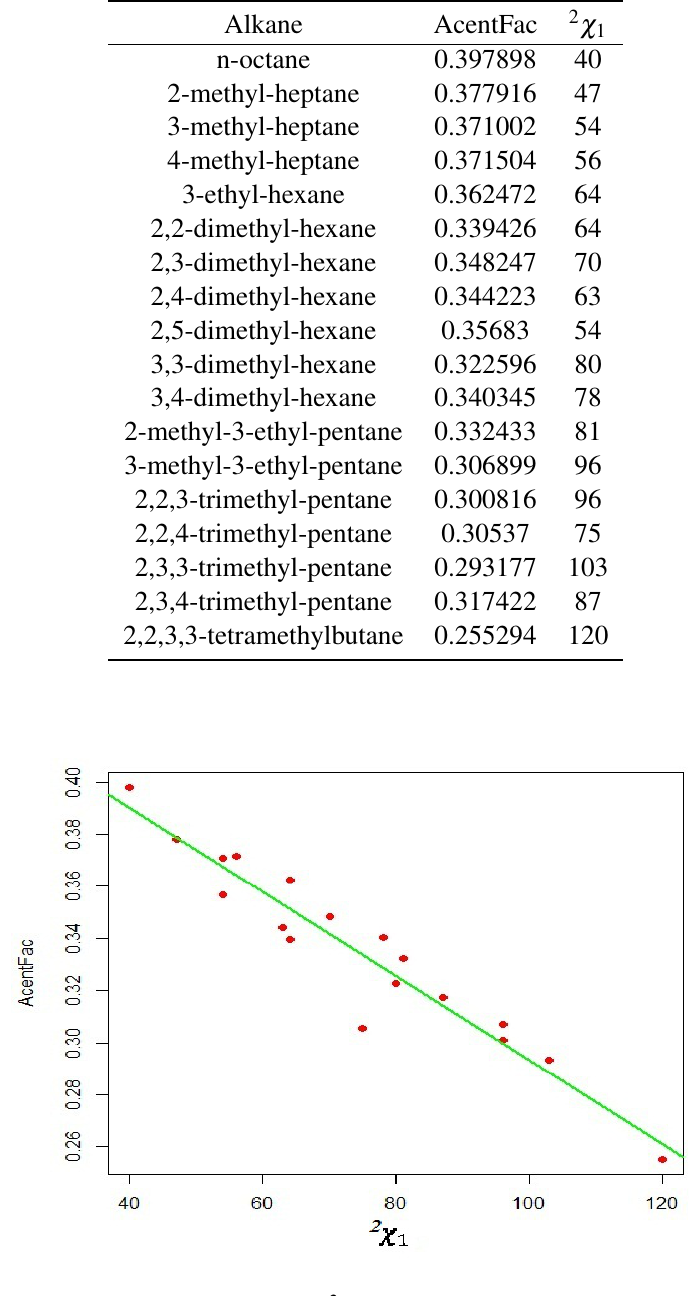
Fig. 1 Scatter diagram of AcentFac on 2 χ 1 , superimposed by the fitted regression line. The values of ( 2 , 1 ) -connectivity index against values of acentric factor of an octane isomers are plotted in Fig. 1. The absolute value of correlation coefficient between AcentFac and 2 χ 1 is 0.95802 and with standard error